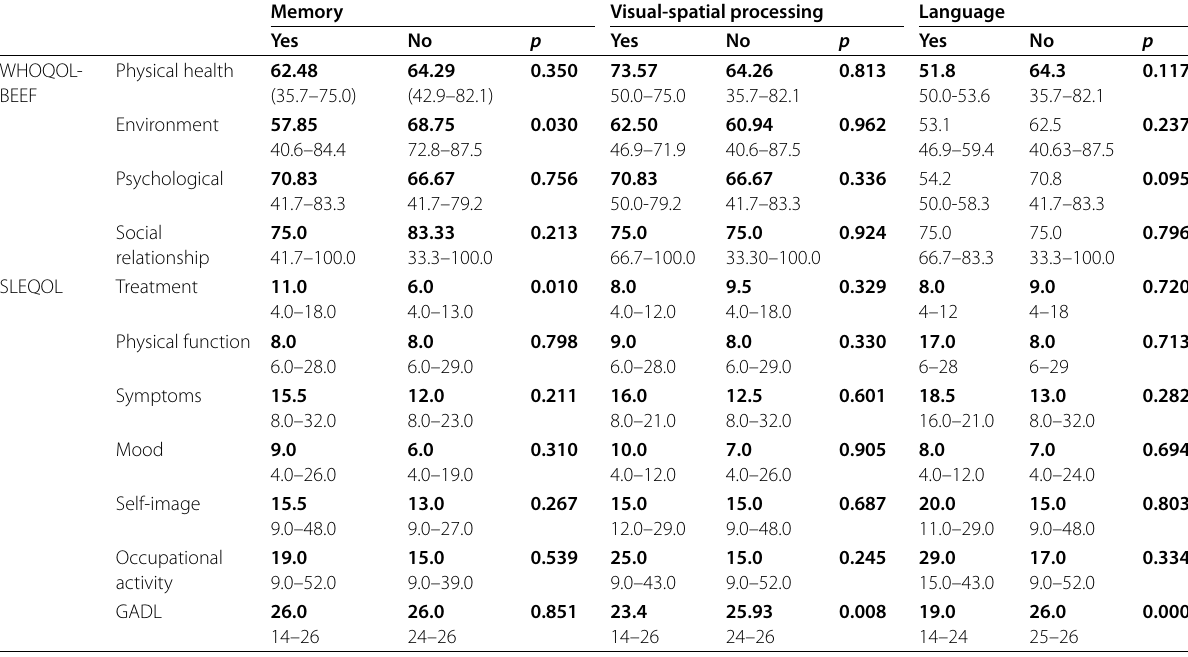
Table 3 Comparative analysis of health-related quality of life in childhood-onset systemic lupus erythematosus patients with and without cognitive dysfunction (n = 39)